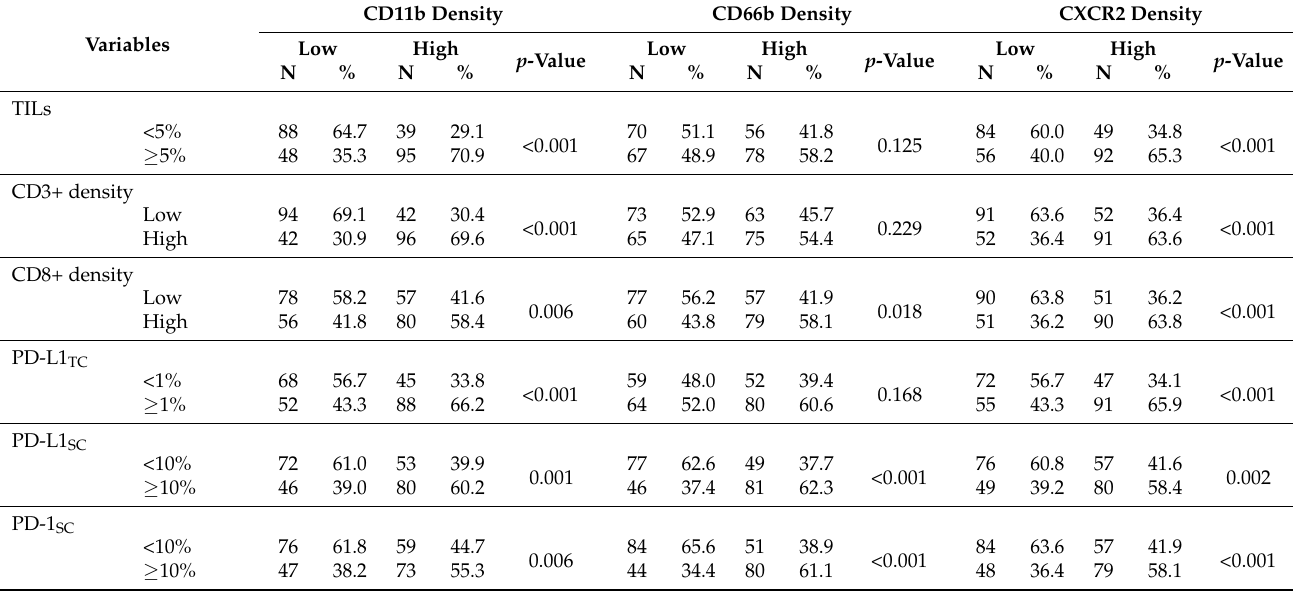
Table 3. Correlations of CD11b, CD66b and CXCR2 expression with immune tumor